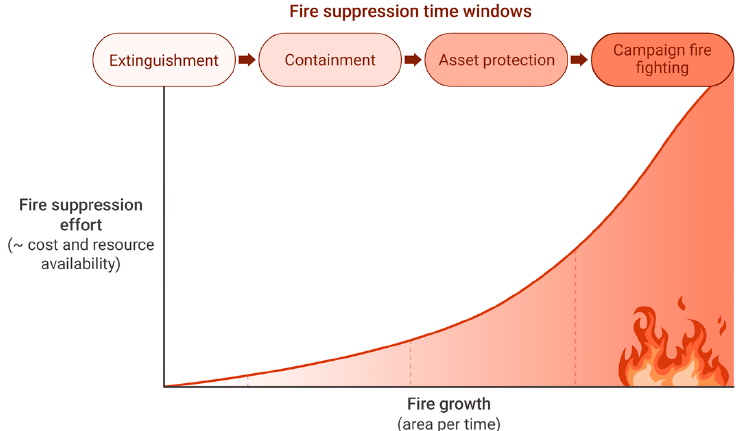
Figure 2. Conceptual relationship with cumulative fire suppression effort/cost with fire growth. Once a fire achieves a critical size, firefighting objectives shift from extinguishment to containment and asset protection and can develop into extremely expensive and long-running firefighting